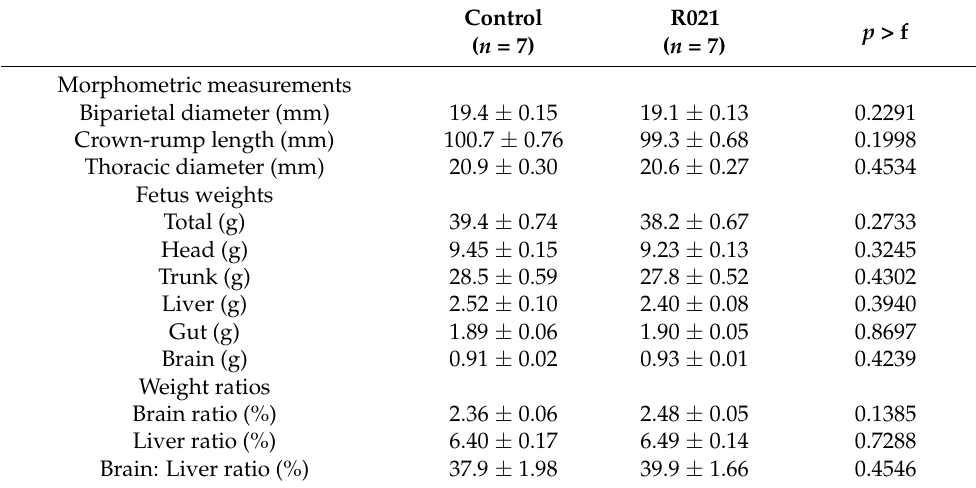
Sex ratio was unbiased by the maternal food restriction during gestation (Figure